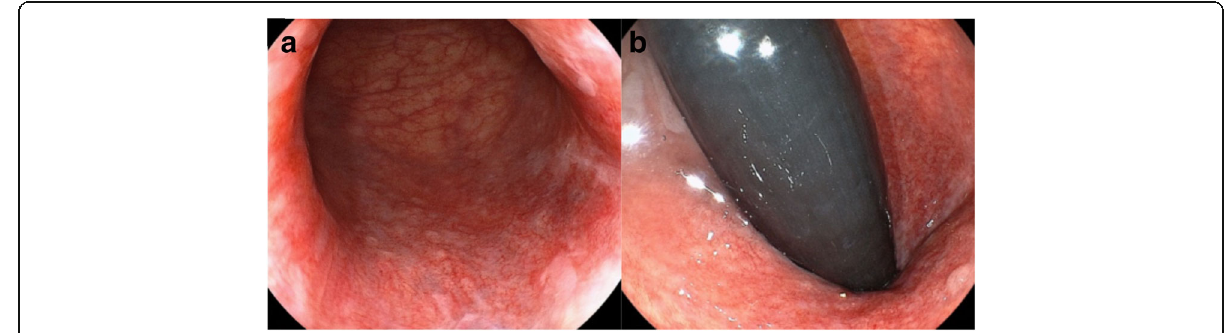
Fig. 2 Colonoscopy. There is no visible lesion in the rectum or anal canal. a Ordinary observation. b Reversal